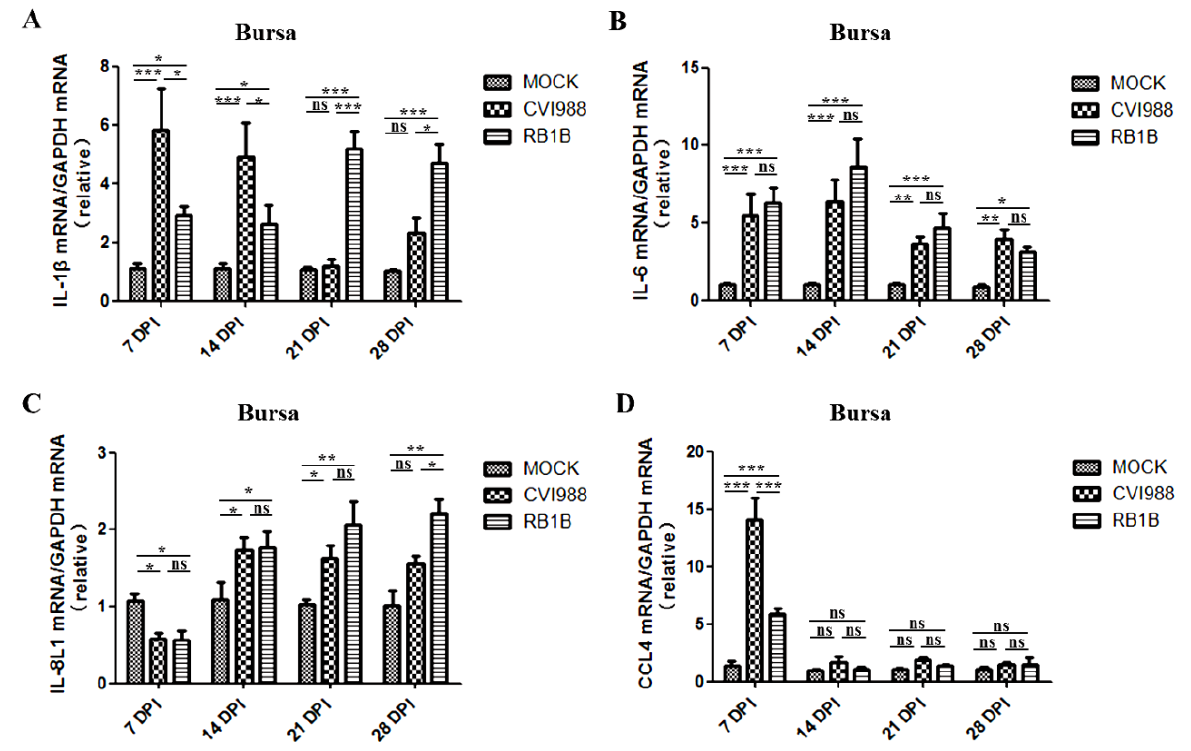
Figure 5. IL-1 β , IL-6, IL-8L1, andCCL4 transcripts in the bursa inoculated with MDV/CVI988 and MDV/RB1B. ( A ) Specific IL-1 β transcripts in the bursa; ( B ) specific IL-6 transcripts in the bursa; ( C ) specific IL-8L1 transcripts in the bursa; ( D ) specific CCL4 transcripts in the bursa. The statistical results are shown as the means ± SD of each experimental group. Statistical significance between each two experimental groups (CVI988 vs. MOCK, RB1B vs. MOCK, CVI988 vs. RB1B) was assessed by t -test (* p < 0.05; ** p < 0.01; *** p < 0.001; ns, no significance).